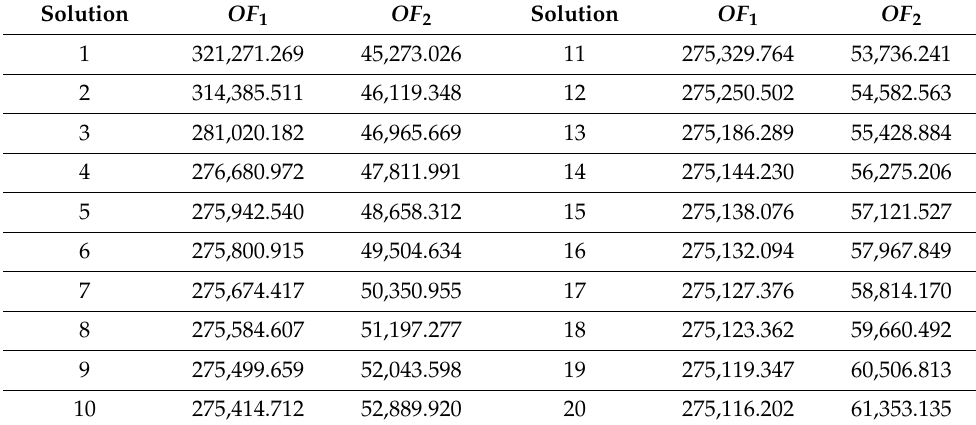
Table 14. Objective function values for the large-sized test